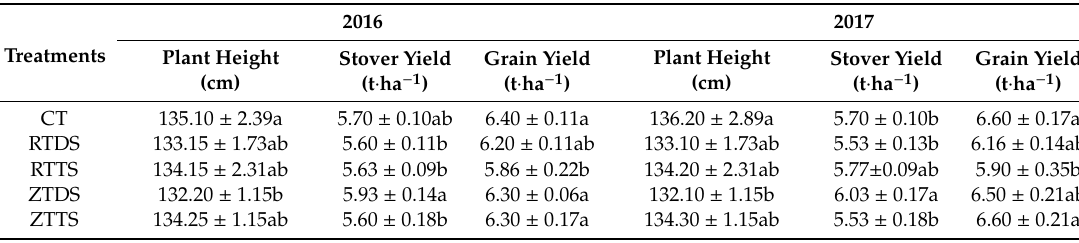
Table 3. Growth and yield parameters of